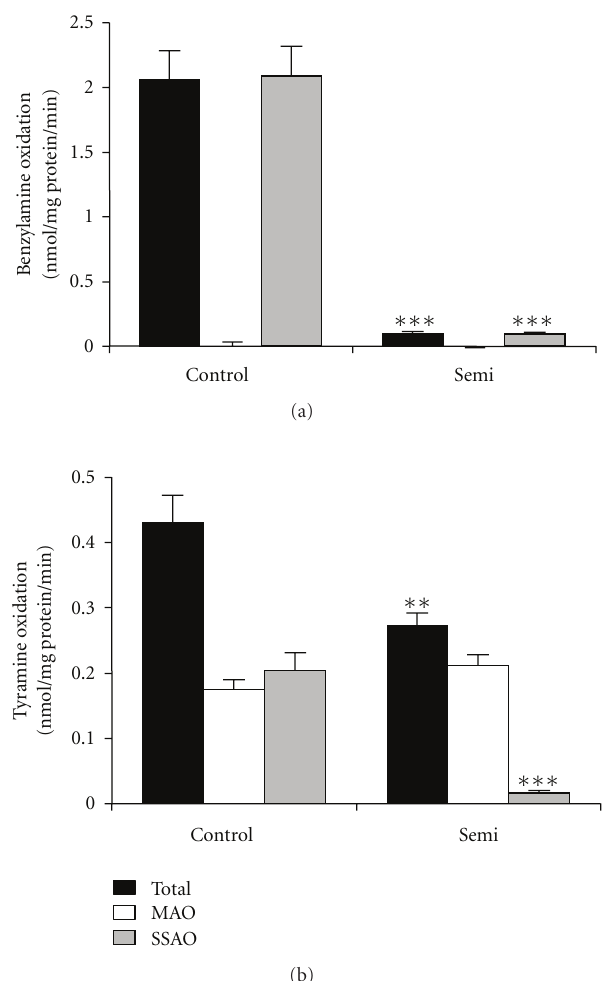
Figure 5: Influence of 8-week oral treatment with semicarbazide on the benzylamine (a) and tyramine (b) oxidation in subcutaneous WAT. Homogenates were preincubated for 15 minutes without (total oxidation, black columns), with 0.5mM pargyline (in order to determine pargyline-sensitive component as MAO, open columns), or with 1mM semicarbazide (to determine the semicarbazide- sensitive component as SSAO, shaded columns). Then, they were incubated for 30 minutes in the presence of 0.1 mM benzylamine (a) or 0.5 mM tyramine (b). Mean ± SEM of 6 determinations. Di ff erent from corresponding control at ∗∗ P < . 01, ∗∗∗ P < . 001.